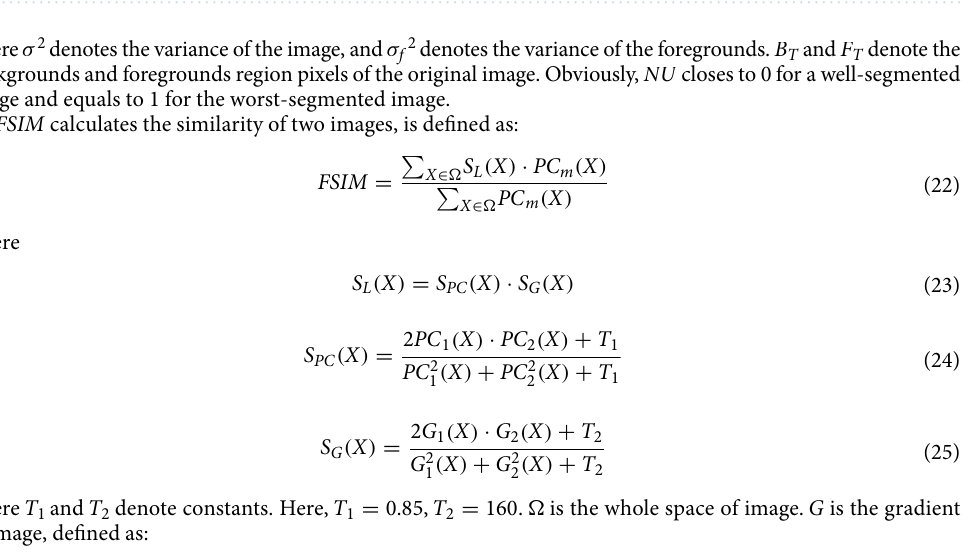
Figure 2. Two examples of synthetic images. ( a ) “Circles” image. ( b ) Noised “Circles” image. ( c ) Histogram of the noised “Circles” image. ( d ) Ground-truth image of noised “Circles”. ( e ) “Squares” image. ( f ) Noised “Squares” image. ( g ) Histogram of the noised “Squares” image. ( h ) Ground-truth image of noised